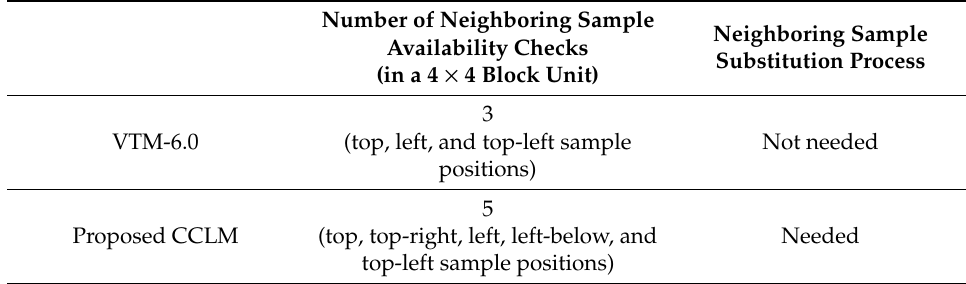
Table 1. Comparison of the number of neighboring sample availability checks and the need for neighboring sample substitution process, between VTM-6.0 and the proposed CCLM, in the case of the LT_CCLM